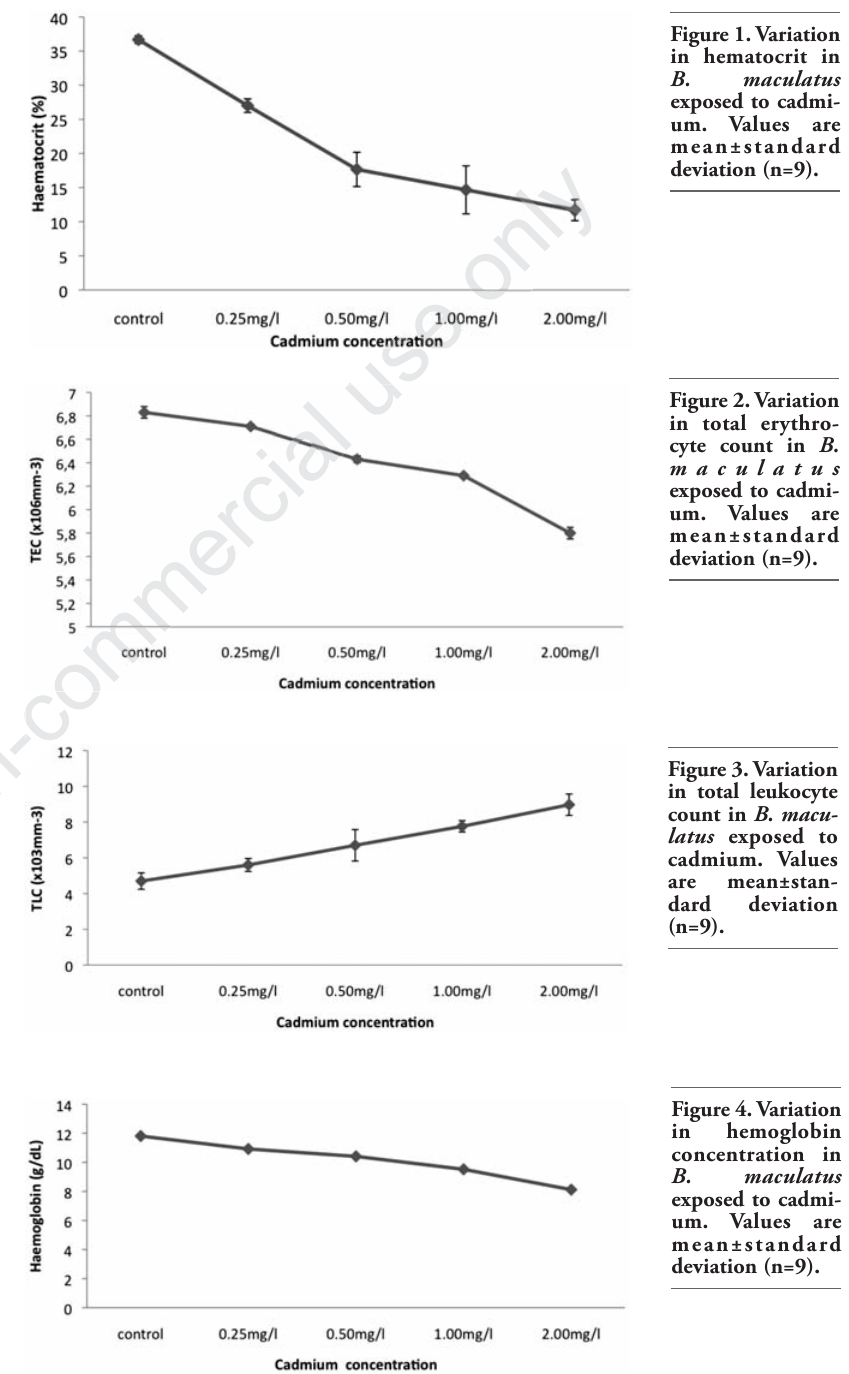
Figure 1. Variation in hematocrit in B. maculatus exposed to cadmi- um. Values are mean±standard deviation (n=9).